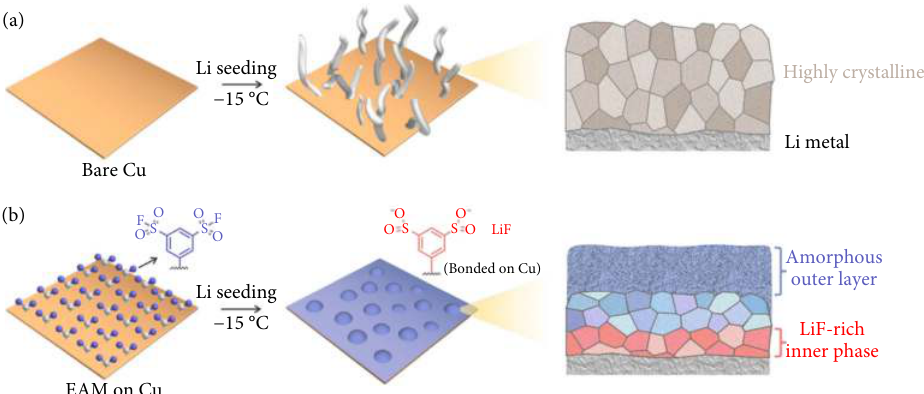
Fig. 7 A multilayered artificial SEI formed on the Cu substrate with EAM regulated structure and chemistry (reprinted with permission from Ref. [85], © The Author(s), under exclusive licence to Springer Nature Limited